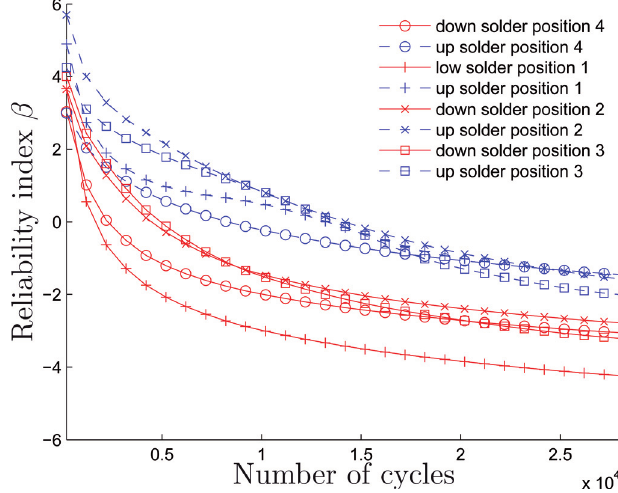
Fig. 5. Evolution of the reliability index β for the target number of